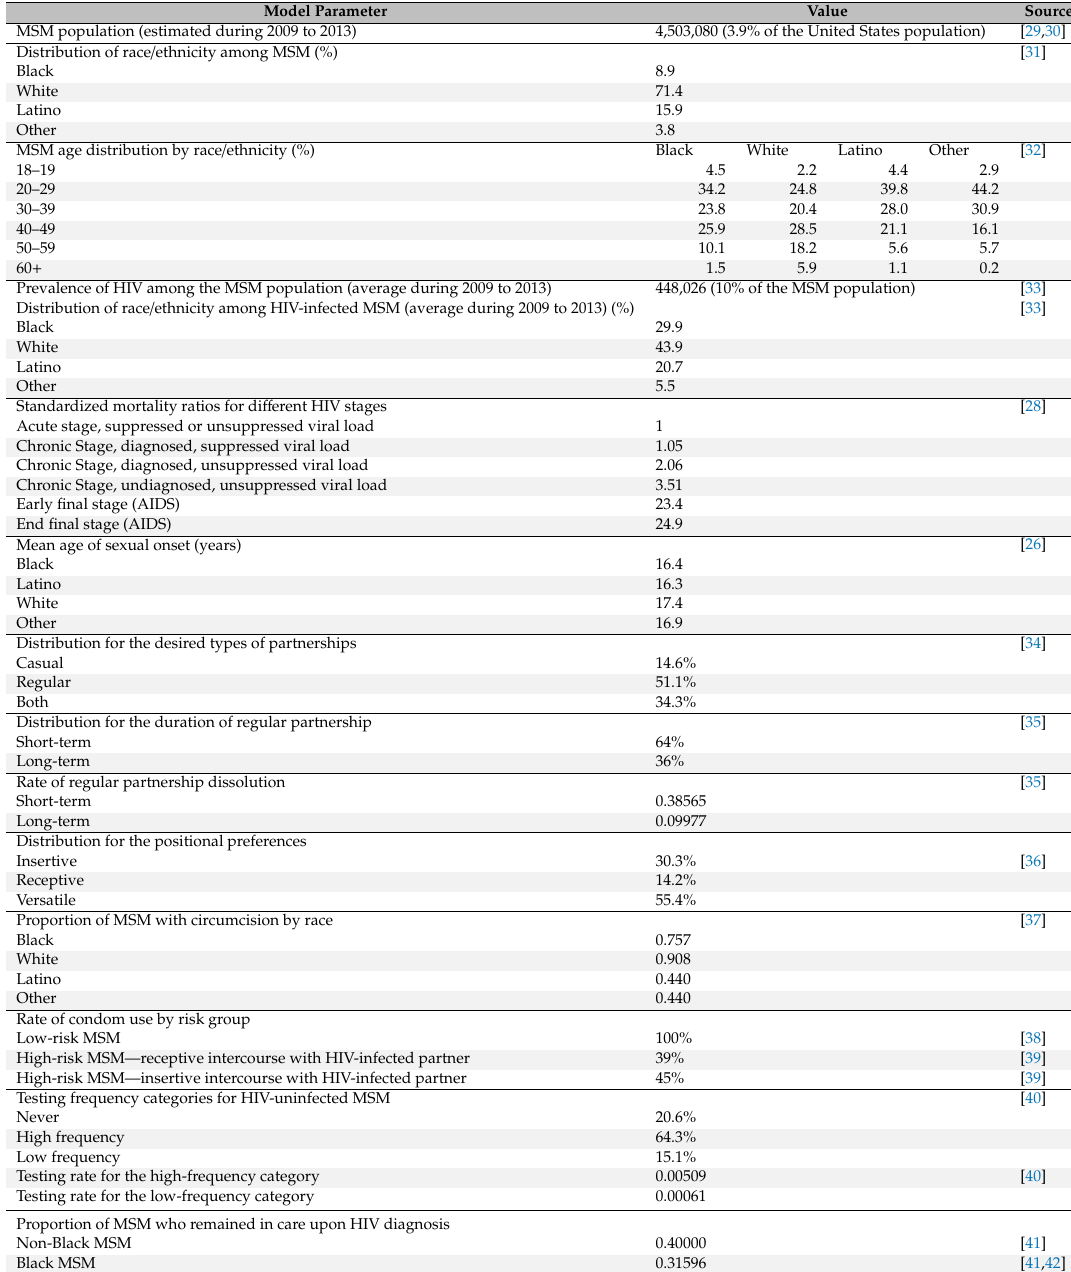
Table 2. HIV epidemic and transmission risk factors among MSM in the United States Model